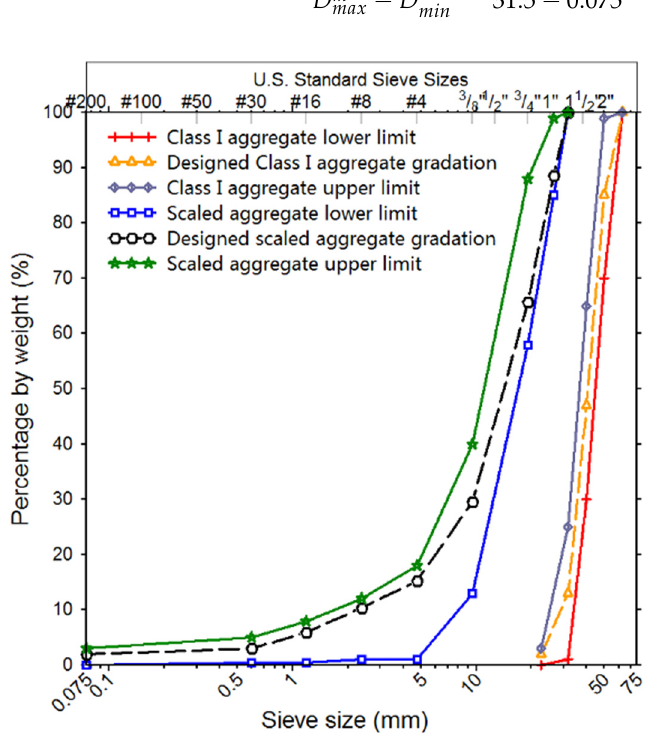
Figure 1. Illustration of original and scaled aggregate gradation curves.